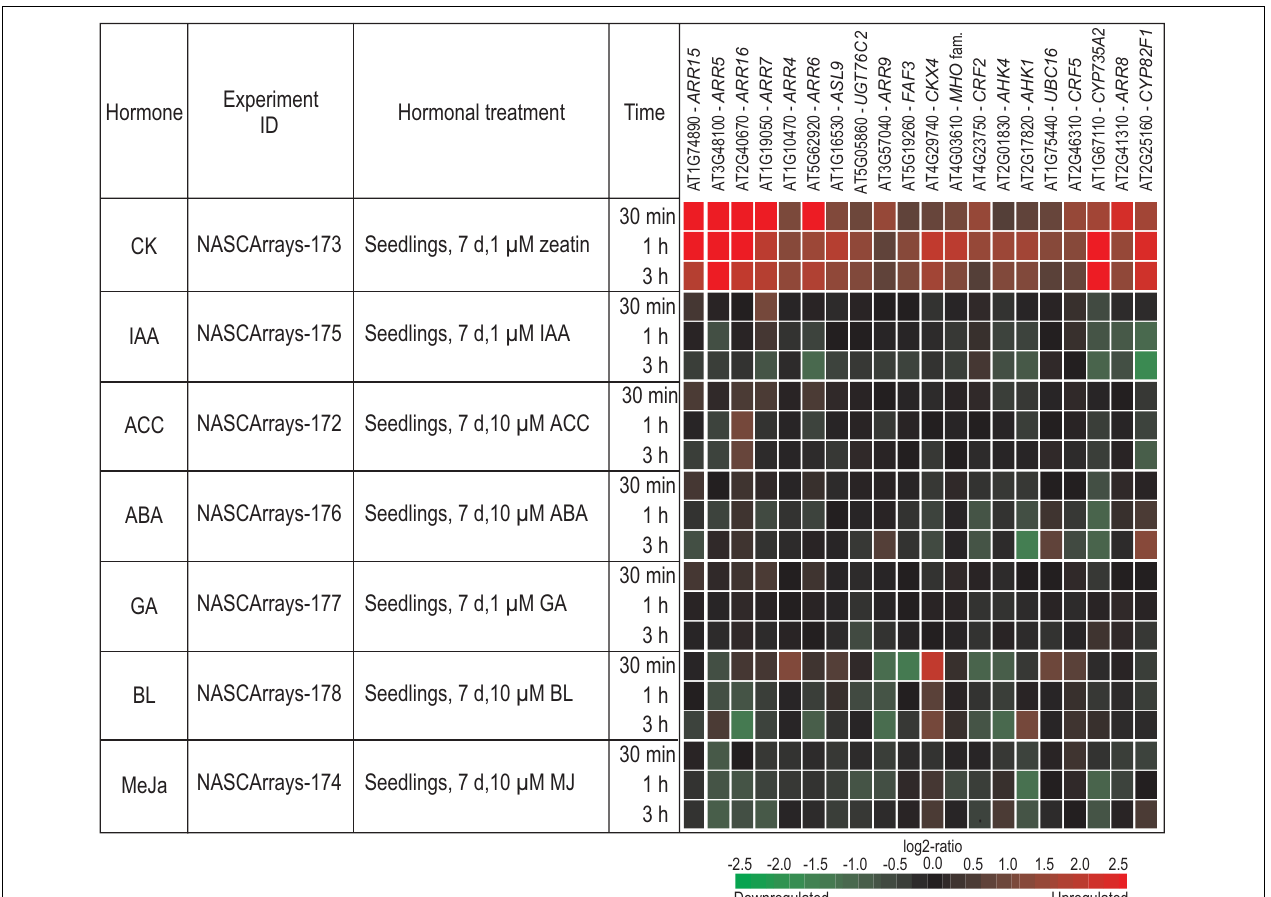
hormone-treated and mock-treated samples.The resulting heatmap is color coded as indicated and thus reflects the up- (red color) or downregulation (green color) of genes. Each experiment can be retrieved from the NASCArrays database (Craigon et al., 2004) by using their unique ID. Abbreviations used in the figure: d, days; h, hours; min, minutes; μ M, micromolar; CK, cytokinin; IAA, indole-3-acetic acid;